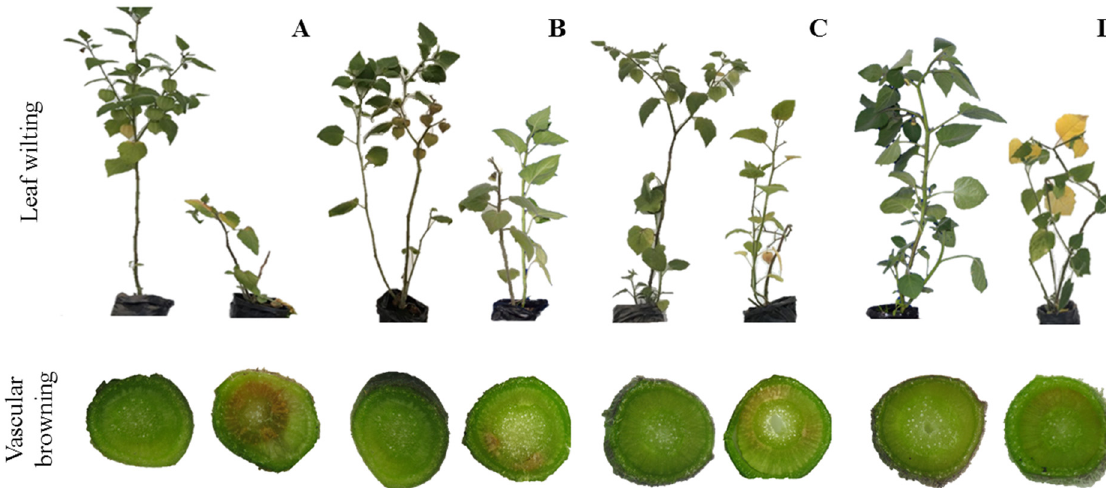
Figure 1. Vascular wilt and vascular browning symptoms in cape gooseberry seedlings infected by Fusarium oxysporum f. sp. physali (Foph) under treatments with mixtures of biological control agents and organic additives 50 days after inoculation (DAI). The image shows control seedlings (Foph − ) on the right and pathogen control seedlings (Foph + ) on the left. ( A ). Symptoms in cape gooseberry seedlings without any treatment. ( B ). Seedlings treated with the mixture T. virens + B. velezensis (Mix). ( C ). Seedlings with applications of the mixture T. virens + B. velezensis with the addition of burnt rice husk (MixRh). ( D ). Seedlings with the application of the mixture T. virens + B. velezensis and the addition of chitosan (MixChi).